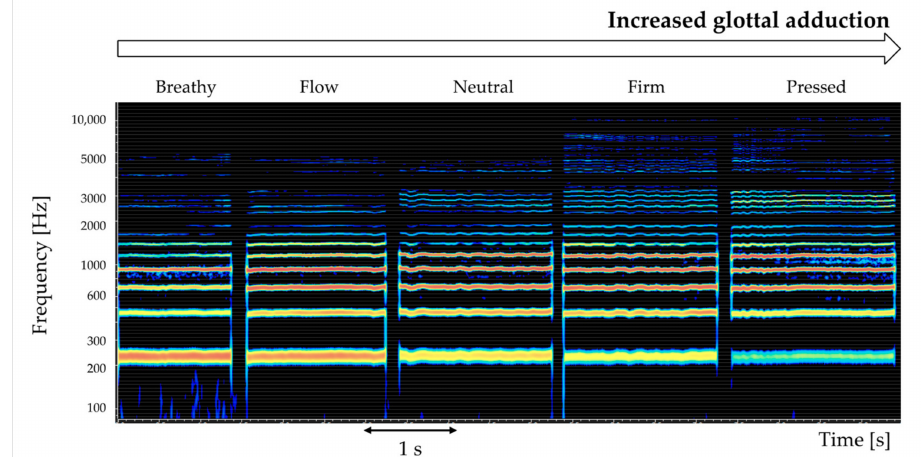
Figure 18. Narrow-band spectrograms of different degrees of glottal adduction displayed by Voce Vista Pro software. Glottal adduction increases from left (breathy) to right